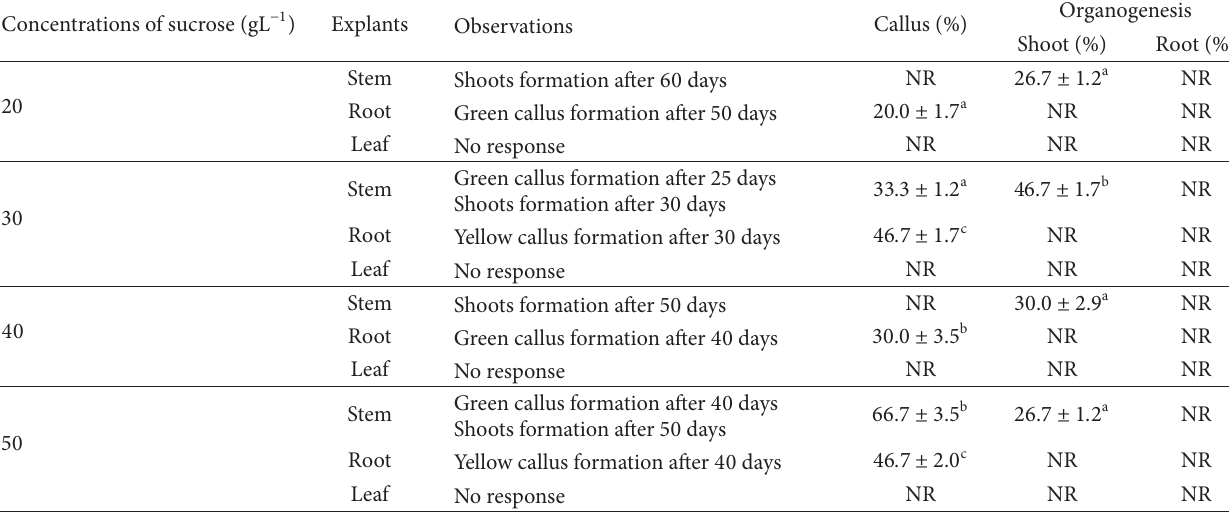
Table 4: The effects of different concentrations of sucrose on stem, root, and leaf explants, cultured on optimum media (MS + 1.5mgL − 1 NAA + 2.0 mgL − 1 BAP) at 25 ± 1 ∘ C. Cultures were maintained at 16 hours of light and 8 hours of darkness, with 1000 lux intensity of light.